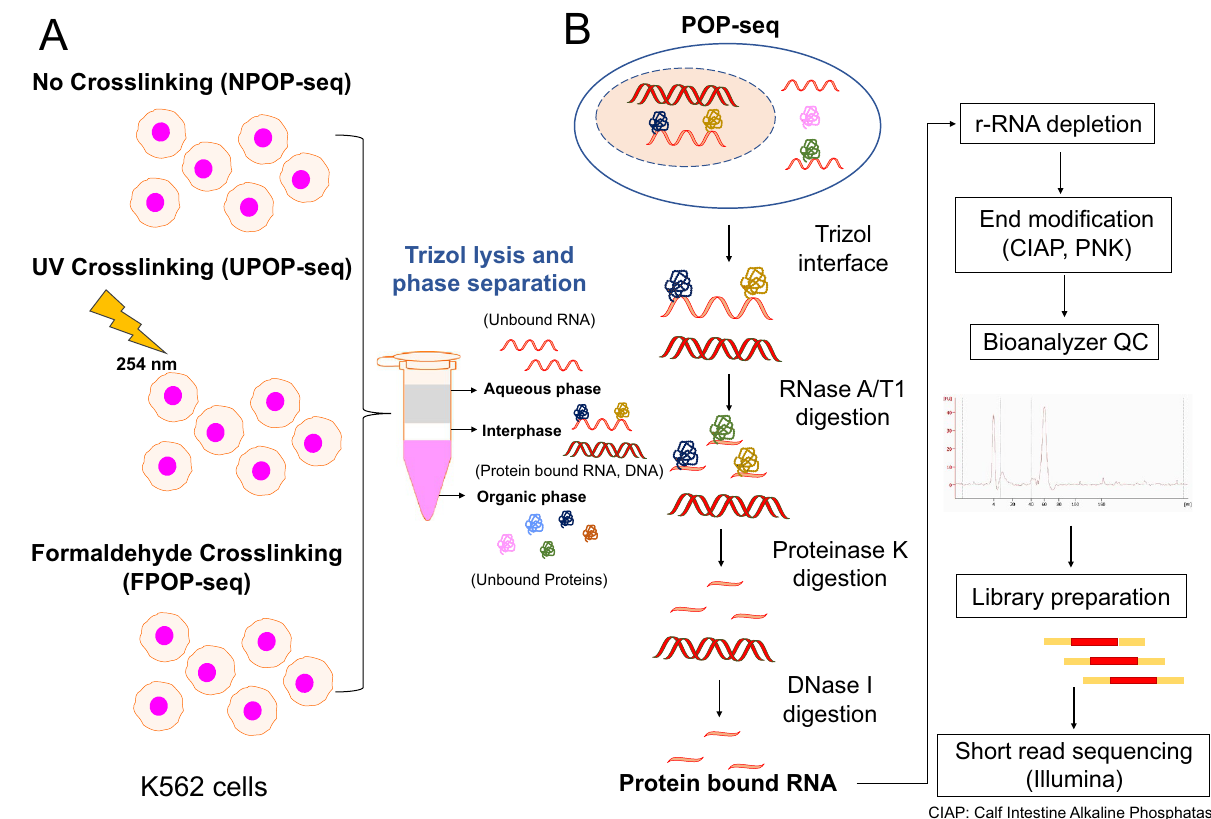
Figure 1. Experimental workflow of POP-seq in K562 cells. ( A ) Three versions of POP-seq, No-crosslinking (NPOP-seq), UV crosslinking, 254 nm (UPOP-seq) and formaldehyde crosslinking (FPOP-seq) generate three phases (aqueous, interphase and organic phase) upon trizol lysis. ( B ) Cell lysates from the POP-seq are digested with RNase A/T1 mix, Proteinase K and DNase followed by r-RNA depletion, RNA quality check and library preparation for short read Illumina